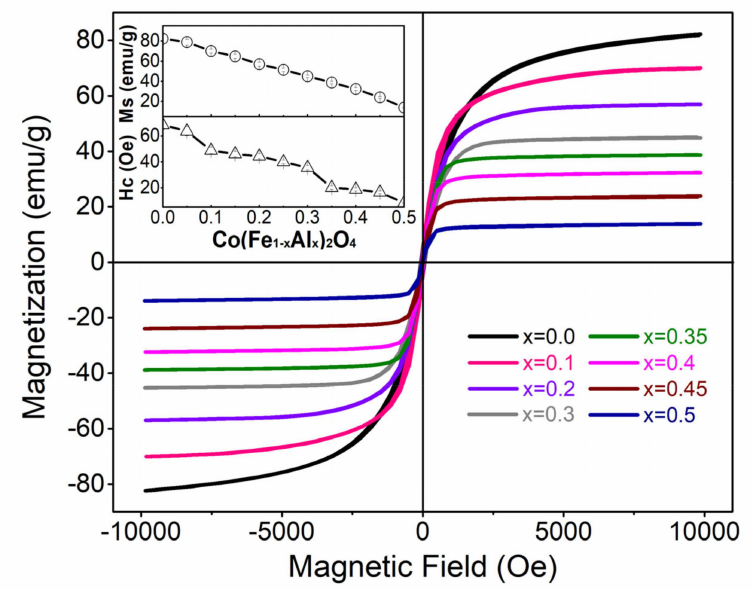
Figure 5. (Color online). The magnetization curves of Co(Fe 1 − x Al x ) 2 O 4 ( x = 0.0, 0.1, 0.2, 0.3, 0.35, 0.4, 0.45, 0.5) at room temperature with the insets showing the saturated magnetization and coercive field for each